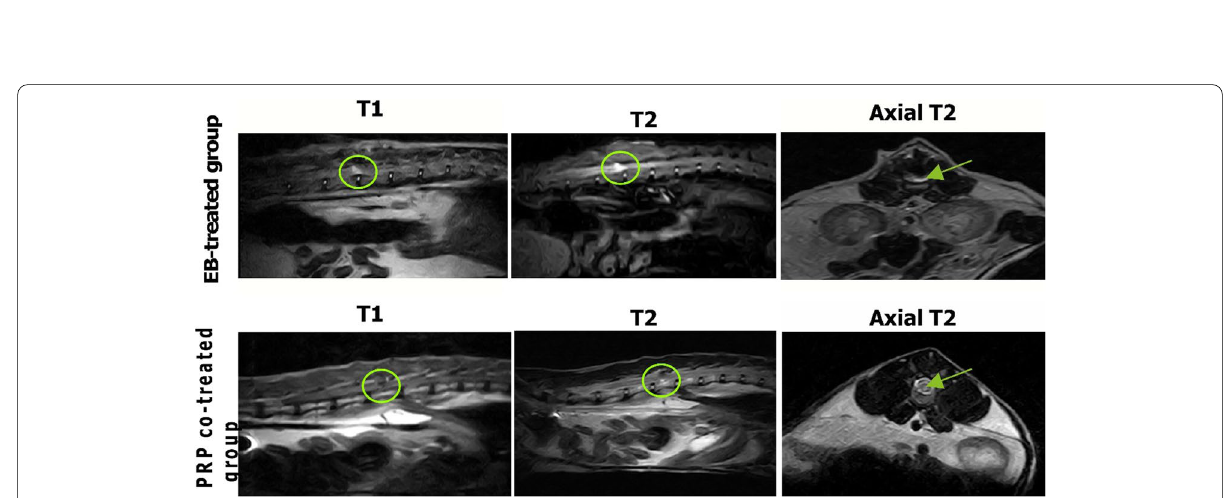
Fig. 5 MRI analysis of the spinal cord. The EB-treated group is characterized by a large hypointense lesion (circle) on sagittal T1 scan and a diffuse hyperintense lesion on sagittal (circle) and axial (arrow) T2 scans while the PRP co-treated group has a small faint hypointense lesion on sagittal T1 scan and a faint hyperintense lesion on sagittal and axial T2 scans showing decreased intensity and extent of the lesion (circle and